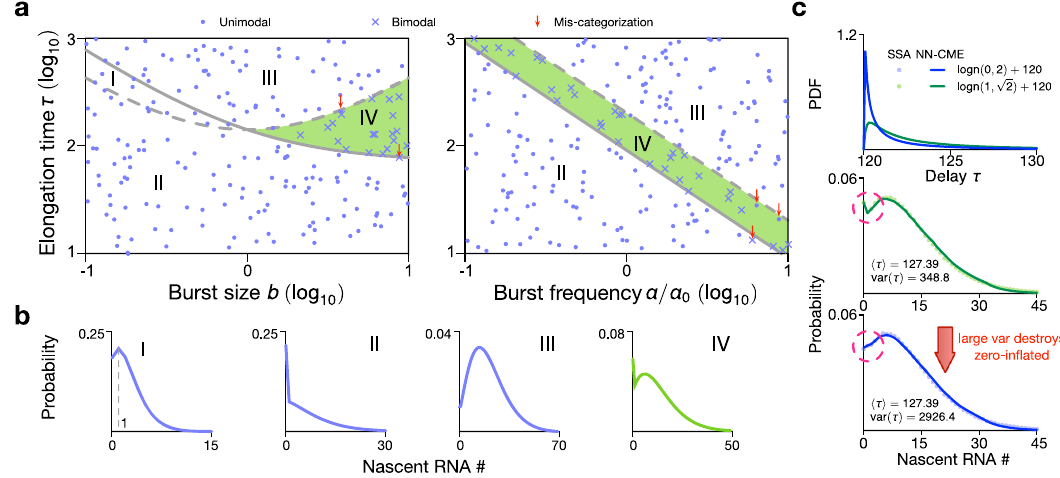
Fig. 5 Stochastic bifurcation diagram for Model III in the bursty regime ( σ off ≫ σ on ) using the NN-CME and comparison with theory. a From an analytical approximation of Model III in the bursty regime, the space is divided into four regions according to the type of distributions (shown in b ): type I, a unimodal distribution with mode = 1; type II, a unimodal distribution with mode = 0; type III, a unimodal distribution with mode > 1; type IV, a bimodal distribution with two modes at zero and a non-zero value. Region IV is highlighted in green since it is a phase that does not exist in the bursty regime of the standard model of gene expression (Model III with delayed degradation replaced by fi rst-order degradation) — this is hence delay-induced bimodality. The lines de fi ning the division of space are: solid line is ð 2 þ 2 b Þ = α and the dashed line is ð b þ 1 b þ 2 Þ = α , which respectively are the lower and upper bounds on τ given by Eq. (9). To check the accuracy of the ANN-aided model approximation for Model III, we used it to compute the NN-CME and then solved using FSP to obtain nascent number distributions for 200 points in parameter space. These are randomly sampled from the space { ρ = 2.11, σ off ∈ 2.11 × [10 − 1 , 10], σ on = 0.0282, τ ∈ [10, 10 3 ]} (left) and { ρ = 2.11, σ off = 0.609, σ on = 0.0282 × [10 − 1 , 10], τ ∈ [10, 10 3 ]} (right). Dots denote parameter sets for which the NN-CME distributions are unimodal and crosses show those for which the distributions are bimodal. The fact that the vast majority of crosses fall in region IV and the dots outside of it shows that the NN-CME agrees with the analytical approximation of Model III (parameter sets, which mismatch between the NN-CME and theory, are highlighted with red arrows and are very few in number). Note in the left fi gure of ( a ), the burst frequency is fi xed to α = 0.0282 (left) while in the right fi gure, we use α = 0.0282 and the burst size is fi xed to b = 3.46. c The NN-CME is learnt from stochastic simulations 0 of the delay model of Model III with the added feature that the elongation time τ is a random variable sampled from two different lognormal distributions (see top fi gure). In the middle and bottom fi gures, we show that the delay-induced bimodality (phase IV) disappears as the variance on the elongation time τ increases at constant mean. The rate constants and other parameters related to the ANN ’ s training are speci fi ed in SI Table